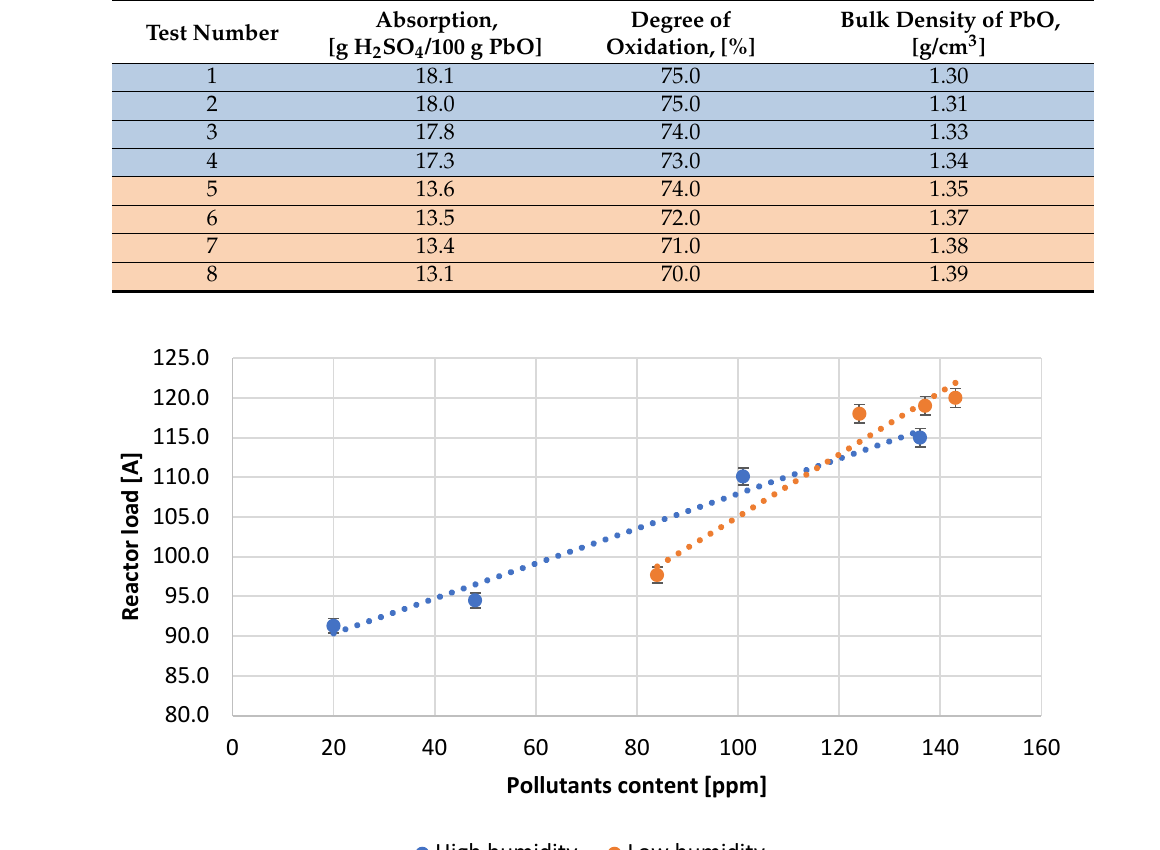
Table 4. Properties of the obtained product (blue color—high humidity; brown color—low humidity).